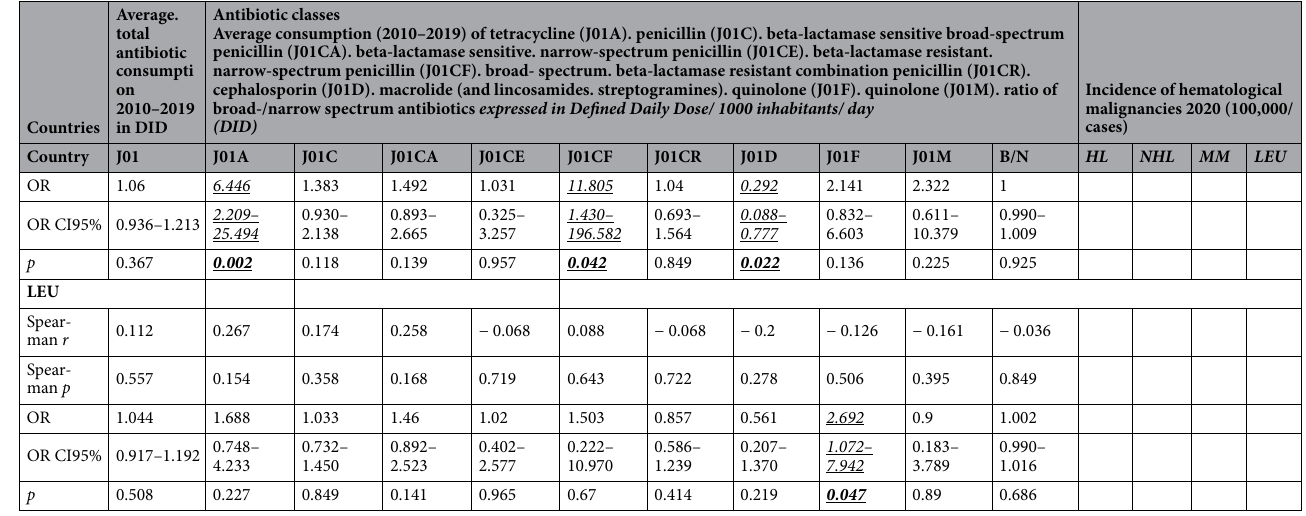
Table 1. Comparison of average antibiotic consumption (2010–2019) expressed in Defined Daily Dose/ 1000 inhabitants/ day (DID), and the incidence of hematologic malignancies estimated for 2020. Spearman correlation indicated (bold, italics , underlined) significant positive associations between HL and tetracycline (J01A), NHL and narrow spectrum, beta-lactamase resistant penicillin (J01CF), MM and tetracycline (J01A), and penicillin (J01C) particularly with the narrow spectrum, beta-lactamase resistant penicillin (J01CF). Negative significance was found (bold, italics ) between NHL and cephalosporin (J01D) and quinolone (J01M). The tendency for a positive correlation between HD and the total consumption of systemic antibiotics (J01, bold) was observed also. A tendency for negative correlation has been detected between MM and cephalosporin (J01D, bold). Multivariate ordinal logistic regression (OR) indicated increased risk between HL and the total consumption of systemic antibiotics (J01 p: 0.038 ), and tetracyclin (J01A p: 0.002 ). Similarly, increased risk has been detected between the MM and tetracyclin (J01A p: 0.02 ), and narrow spectrum, beta-lactamase resistant penicillin (J01CF p: 0.042 ) and decreased risk between cephalosporin and MM (J01D p: 0.022 ). LEU showed increased risk with the consumption of macrolides ( p: 0.047 ). *Countries provided hospital and OPD consumption of antibiotics together.